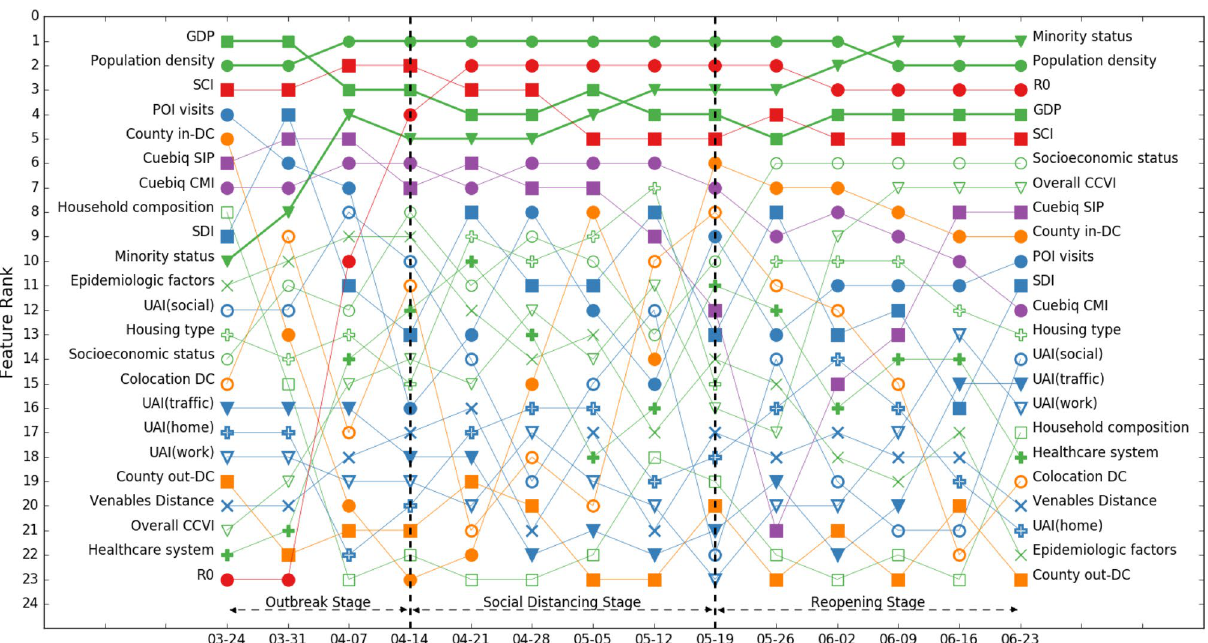
Figure 3. Rank of feature importance of model 1 throughout three stages of COVID-19. Color coding of 23 features: green: social demographic features, blue: population activity features, purple: within-county mobility features, orange: across-mobility features, and red: disease attribute feature and social network structure feature. The legend also distinguishes each feature. Features with greater importance are highlighted with thicker lines. Population density shows high importance throughout three stages of